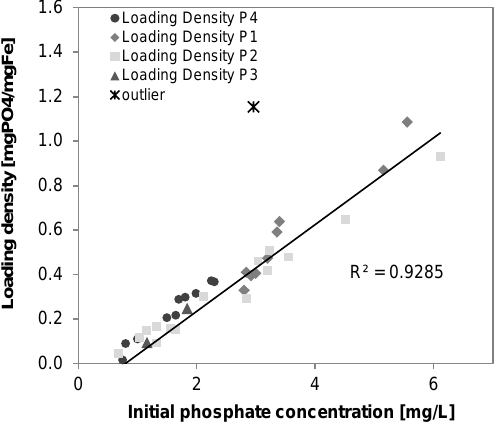
Figure 15. Correlation of phosphate loading densities on iron precipitates and initial phosphate concentration in groundwater (R 2 = 0.86, n = 38).